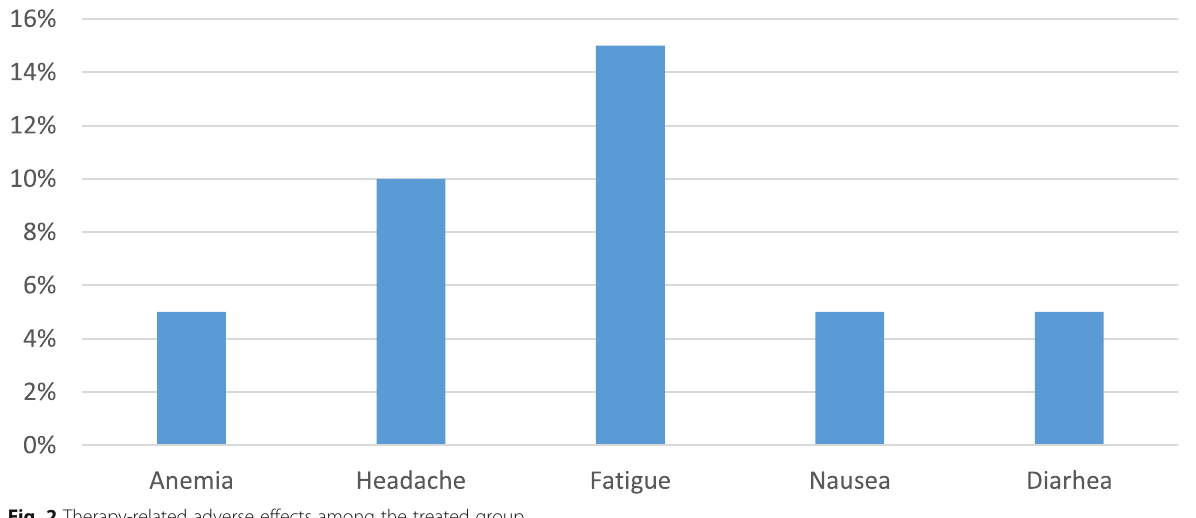
Fig. 2 Therapy-related adverse effects among the treated